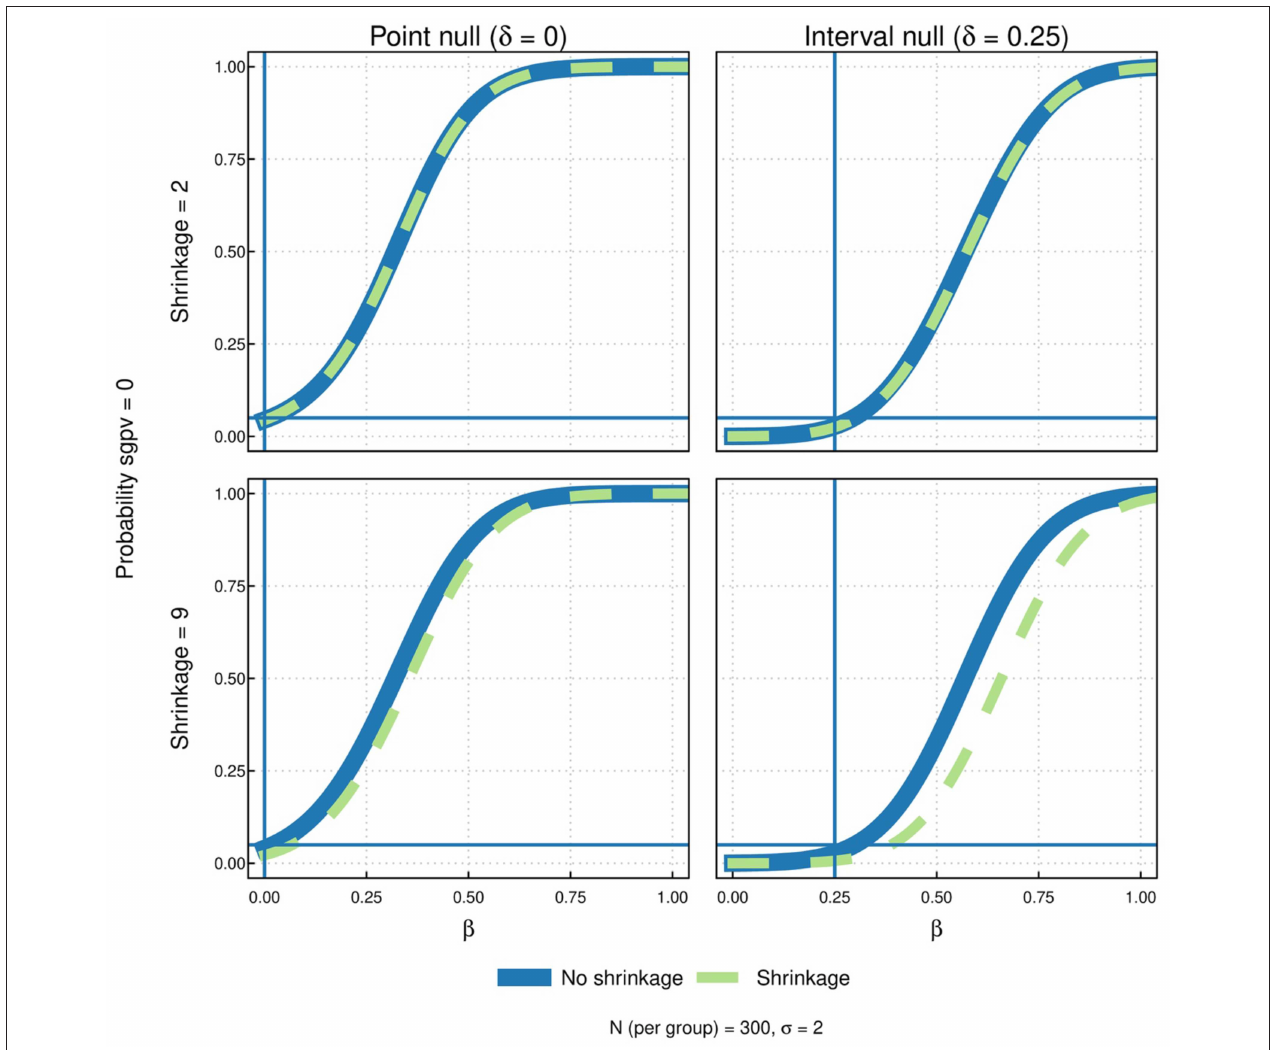
FIGURE 6 | Results of the simulation study with the following factors: degree of shrinkage [mild vs. none (row 1) and extreme vs. none (row 2)] and type of null [point (column 1) and interval (column 2)]. In each of the four graphs, the probability that the SGPV = 0 is plotted as a function of beta for both the shrinkage and no shrinkage intervals. Comparing column 1 to column 2, the estimated probability curves cross 0.05 at the boundary of the respective nulls (0 for the point null and 0.25 for the interval null). For mild shrinkage (row 1), there is little noticeable difference between probability curve estimates with or without shrinkage (solid blue vs. dashed green). More noticeable differences between shrinkage and no shrinkage occur with more extreme shrinkage (row